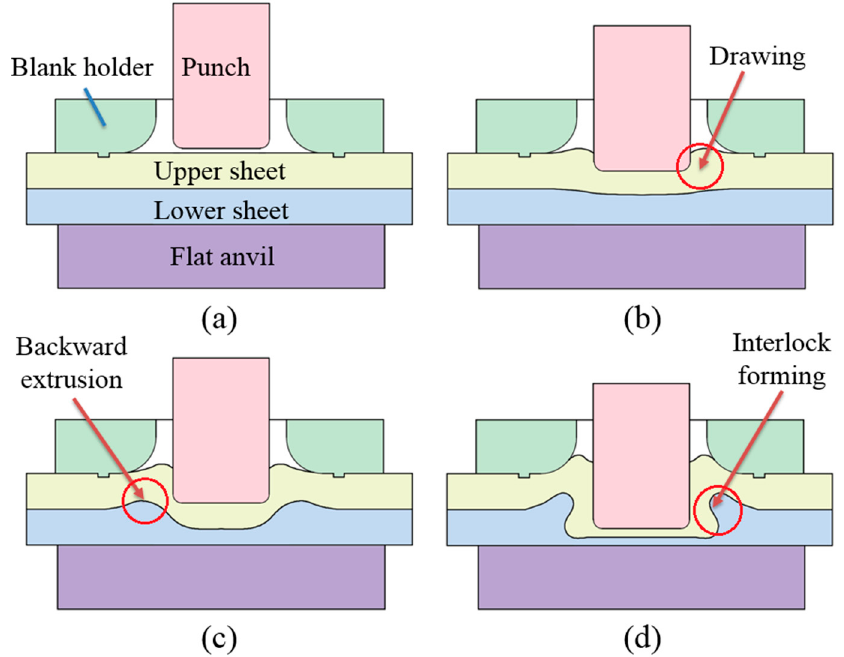
Figure 1. Improved clinching process: ( a ) localized deformation; ( b ) drawing; ( c ) backward extrusion and ( d ) interlock forming.